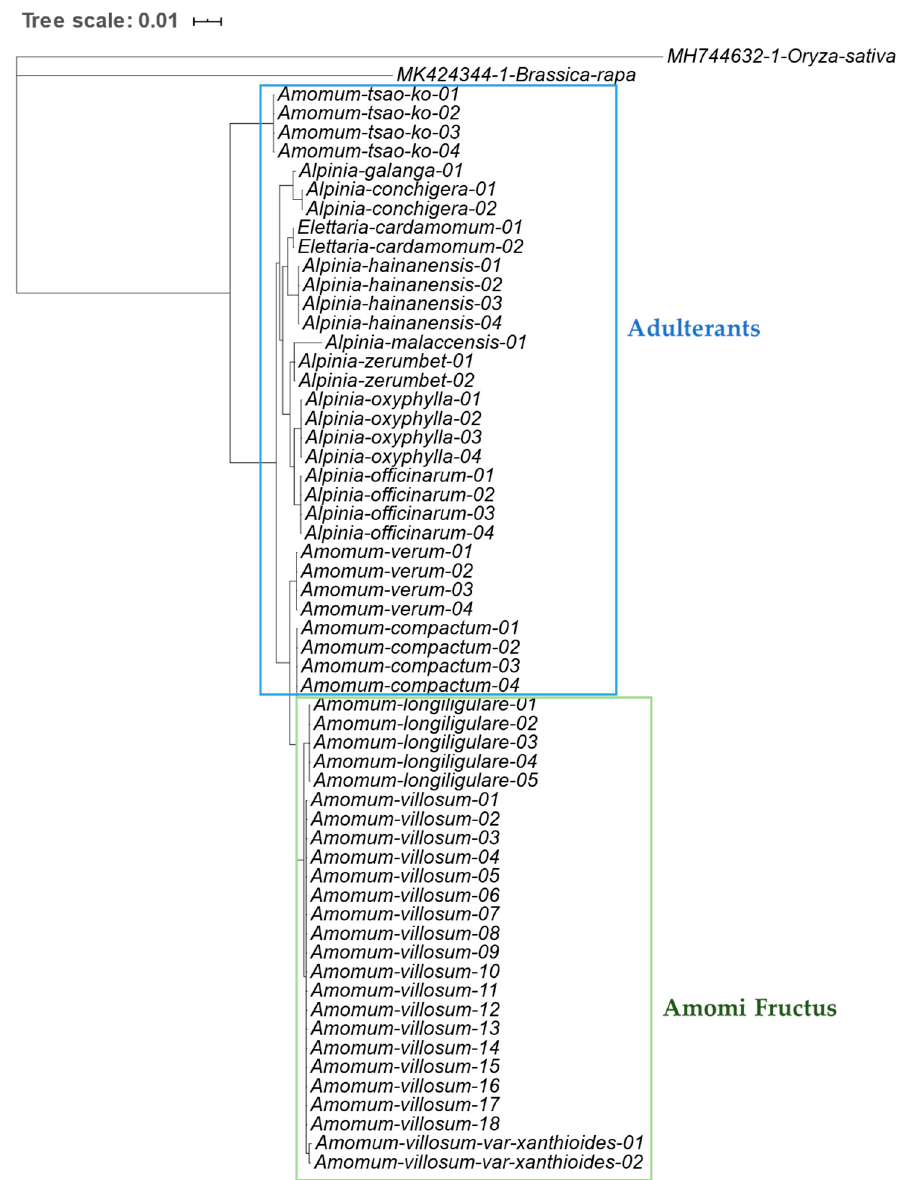
Figure 5. Phylogenetic analysis of Amomi Fructus and its adulterants based on the concatenate nucleotide sequences of four plastid regions ( matK, rbcL, rpoB and trnL-F intergenic spacer) using the MrBayes.